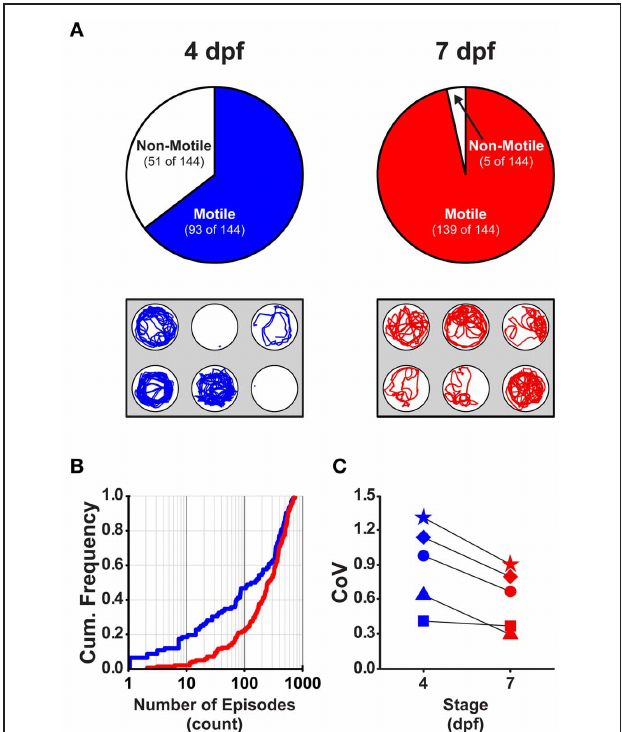
FIGURE 1 | The proportion of motile larvae and the variability among the locomotor properties are different between 4 and 7dpf larvae. (A) Top Row , Pie charts depicting the proportions of motile and non-motile larvae at 4dpf and 7dpf (blue and red, respectively). Bottom Row , Representative trajectory plots for larvae in 6-well behavioral arena plates (30mm well diameter shown); single larva per well. (B) Cumulative frequency plots for the number of swim episodes produced by 4dpf and 7dpf larvae (blue and red, respectively). (C) Plots of the group coefficients of variation (CoV) for all measured locomotor properties at 4dpf ( n = 93) and 7dpf ( n = 139) (blue and red, respectively). Symbols are: circle, episode frequency; square, episode duration; triangle, swim speed; diamond, active swim time; star, total